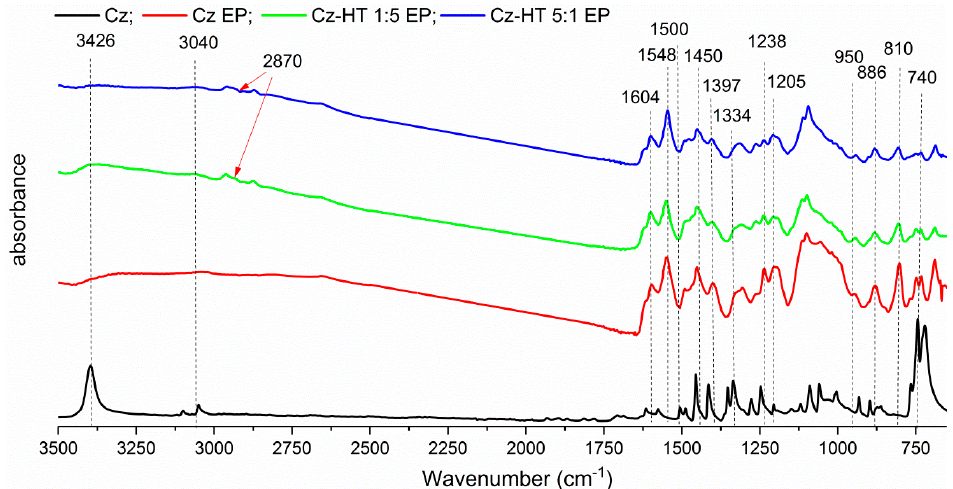
Figure 8. ATR-IR spectra of carbazole, its homopolymer (Cz EP) layer and Cz-HT EP layers.